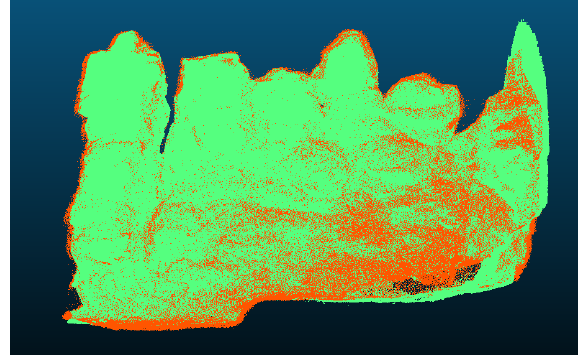
Figure 8 TLS data (green) and SfM data (red)